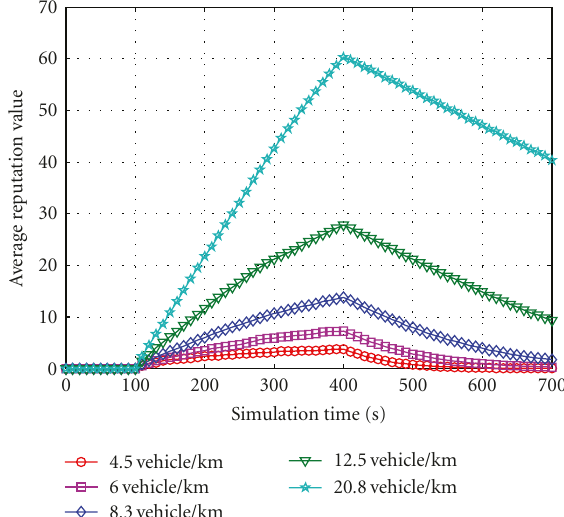
Figure 6: Average accumulation speed of event reputation value to vehicles under di ff erent tra ffi c densities.